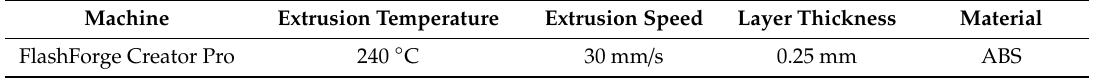
Table 1. Main parameters of 3D printing